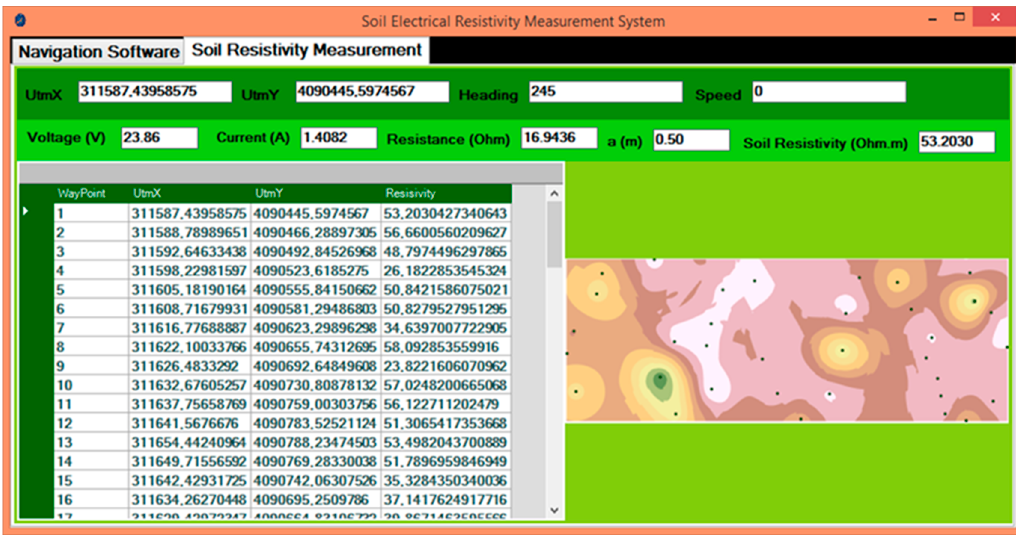
Figure 6. Soil resistivity measurement.